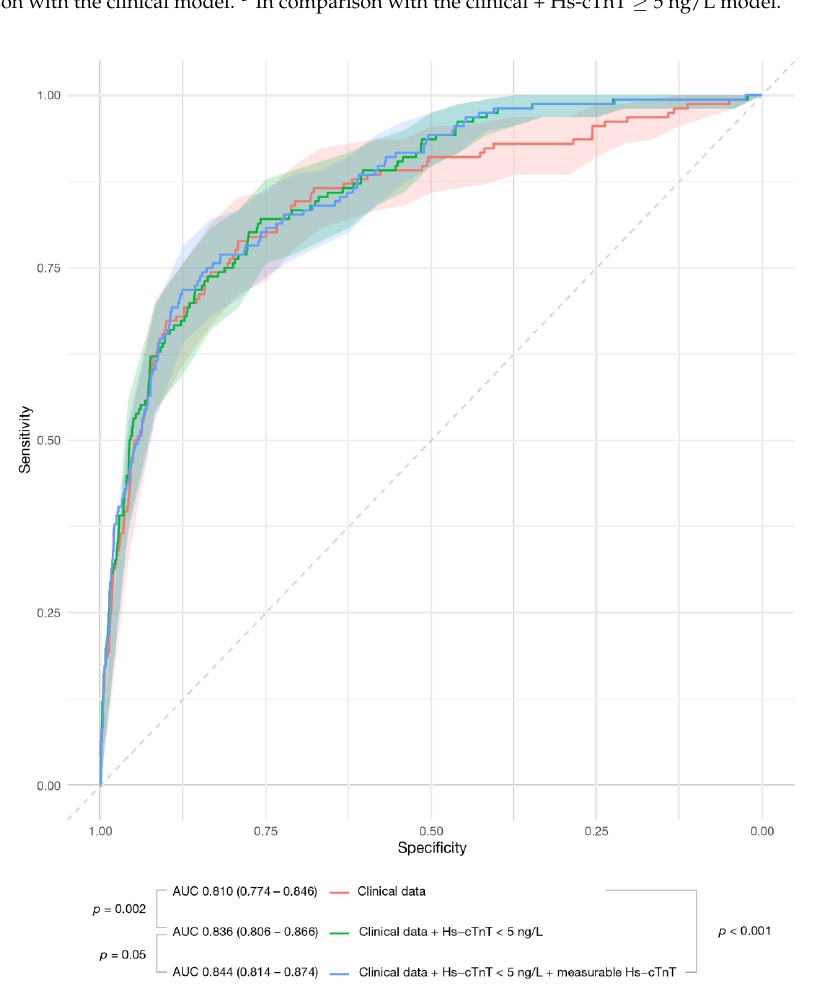
Figure 1. Discrimination accuracy (AUC with the 95% confidence intervals) of the predictive models for the primary endpoint. AUC = area under the receiver operating characteristic curve. According to IDI and continuous NRI, the addition of undetectable hs-cTnT reclas- sified the risk over the clinical model (Table 4). Measurable hs-cTnT did not provide further risk reclassification. Table 4. Risk reclassification for the primary endpoint after combining hs-cTnT and clinical data.